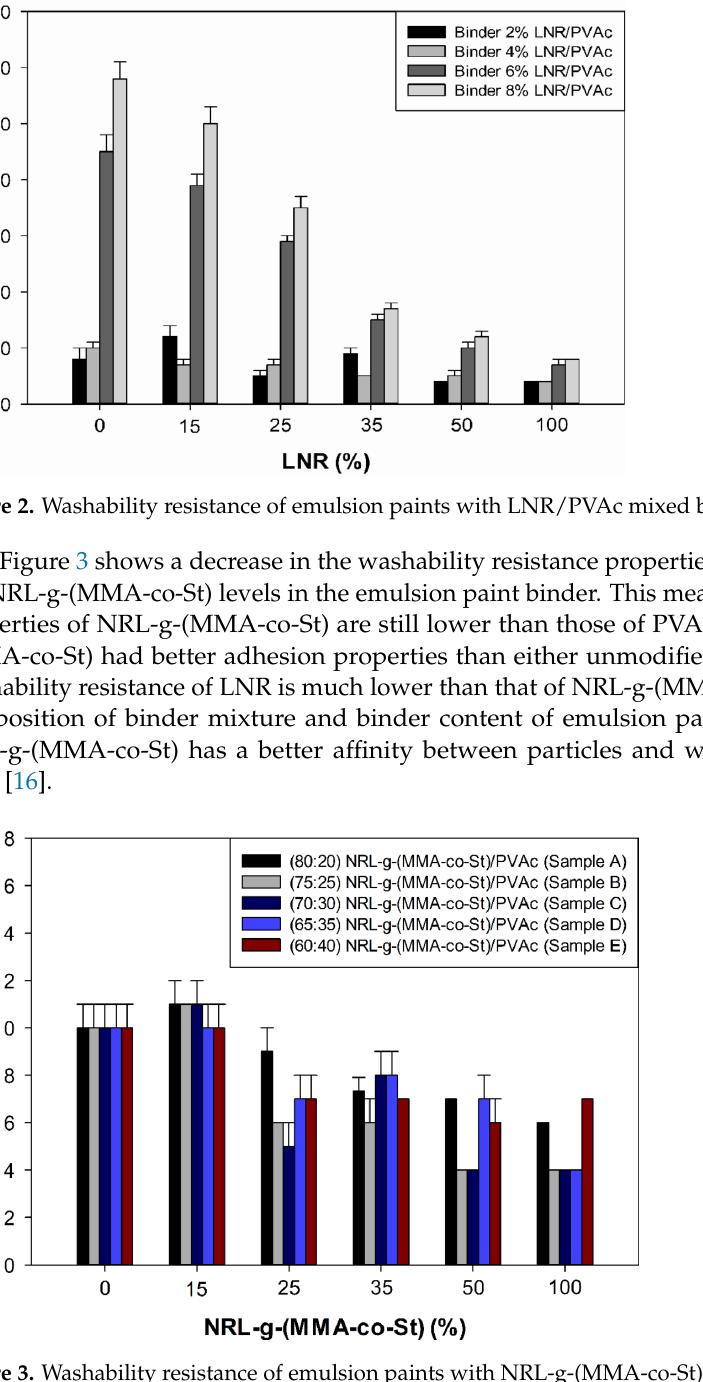
Figure 3. Washability resistance of emulsion paints with NRL-g-(MMA-co-St)/PVAc binder mixture. The low adhesion property of NRL-g-(MMA-co-St) compared to PVAc is because NRL-g-(MMA-co-St), which coats emulsion paints, oxidizes faster than PVAc. The oxi- dation process in the emulsion paint layer will not stop until the binder layer dries [17]. A suitable emulsion paint binder must also pay attention to the material’s oxidation abil- ity, chemical resistance, and mechanical properties [18]. Emulsion paint with a binder NRL-g-(MMA-co-St) has resistance to more extreme temperatures. This is due to grafted styrene and MMA monomers in the rubber polymer chain. Styrene and MMA monomers bonded to rubber components can increase the rubber latex’s elasticity, tensile strength, and durability